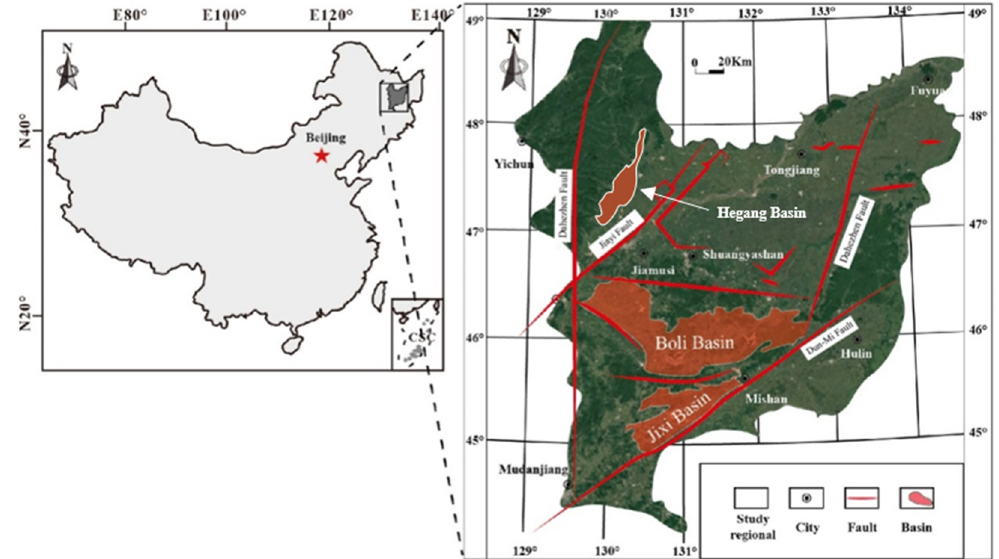
Figure 1. Sampling location of Sangjiang-Muling coal-bearing basins, Northeast China.